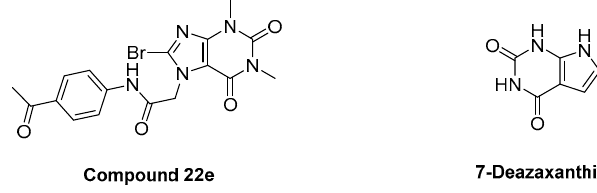
Figure 2. Structures of compound 22e from [14] and 7-deazaxanthine.